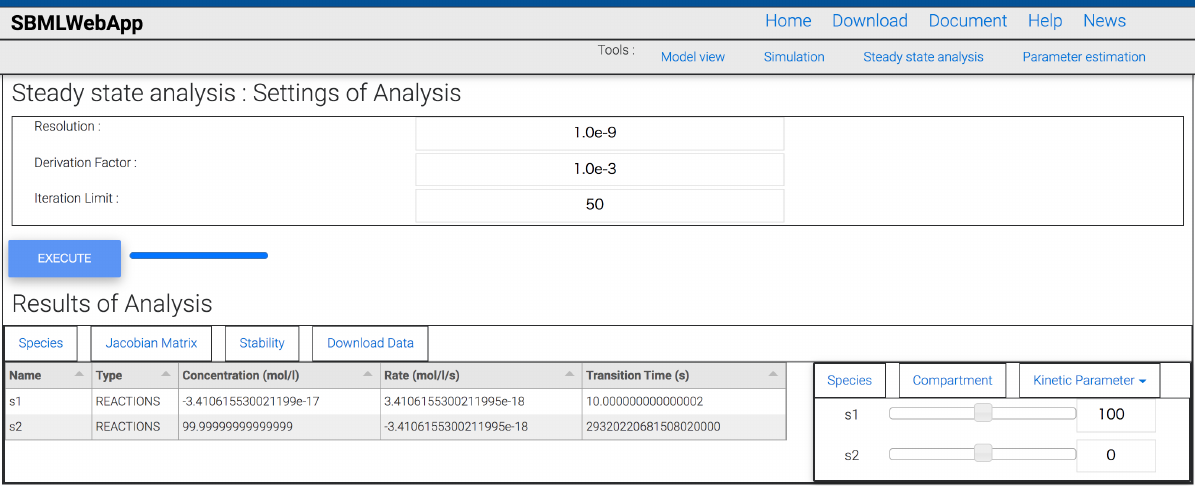
Figure 3. The result of a steady-state analysis. The result shows the type of species, concentration in the steady-state point, the rate at this point, and transition time to reach this point from the initial value of each